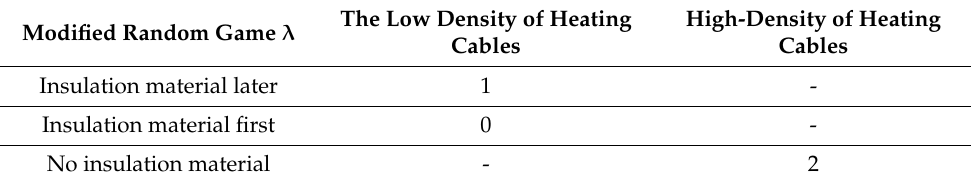
Table 3. Modification of the bell test for the reproducibility